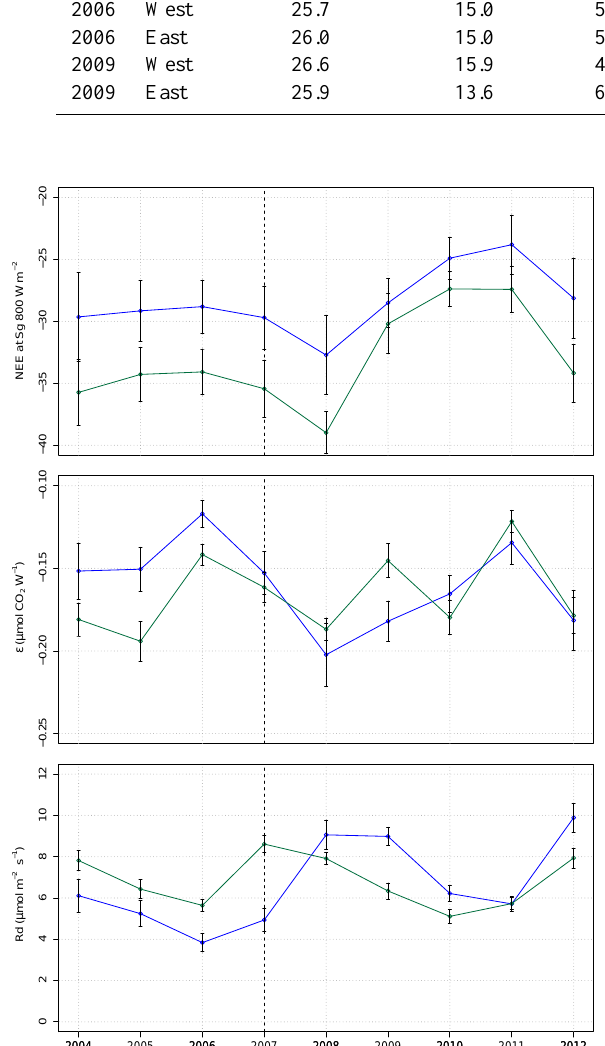
Figure 5. Inter-annual variation in summer (July and August) day- time light response model parameters for (a) NEE 800 , (b) ε and (c) R d for the east sector (blue line with open circles) and west sector (green line with open circles), with error bars representing ± 1SE, at the Straits Inclosure, Alice Holt Forest.